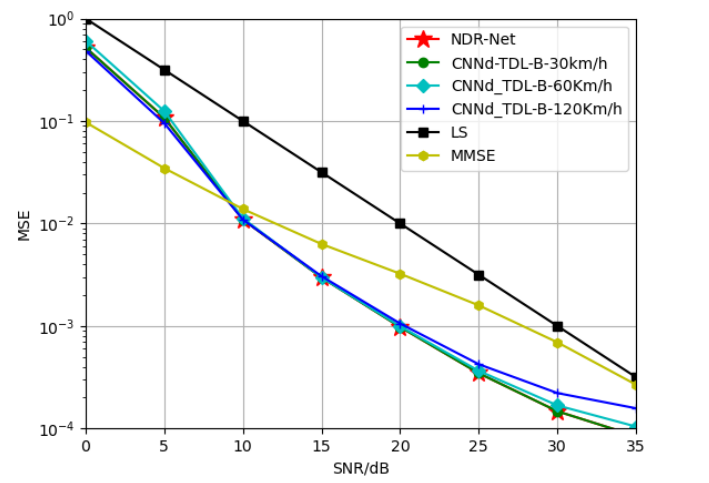
Figure 7. Generalization performance of TDL-B channels at different training velocities when testing velocity = 120